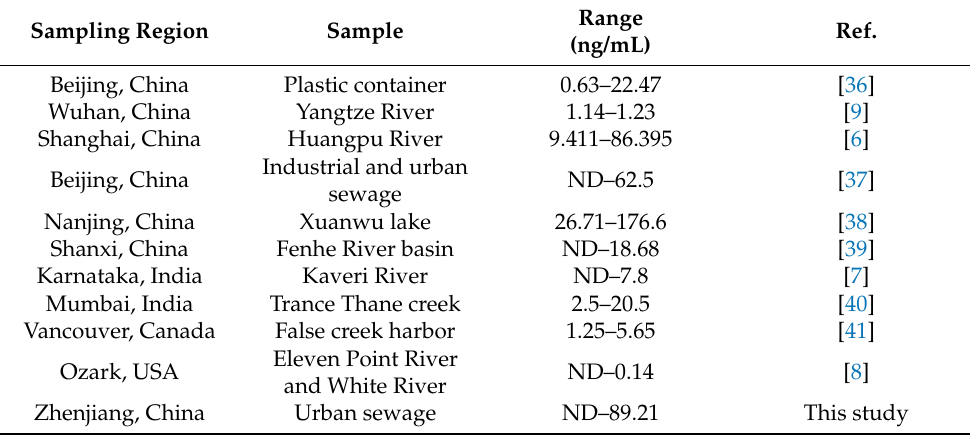
Table 4. The review of BBP occurrence in environmental water